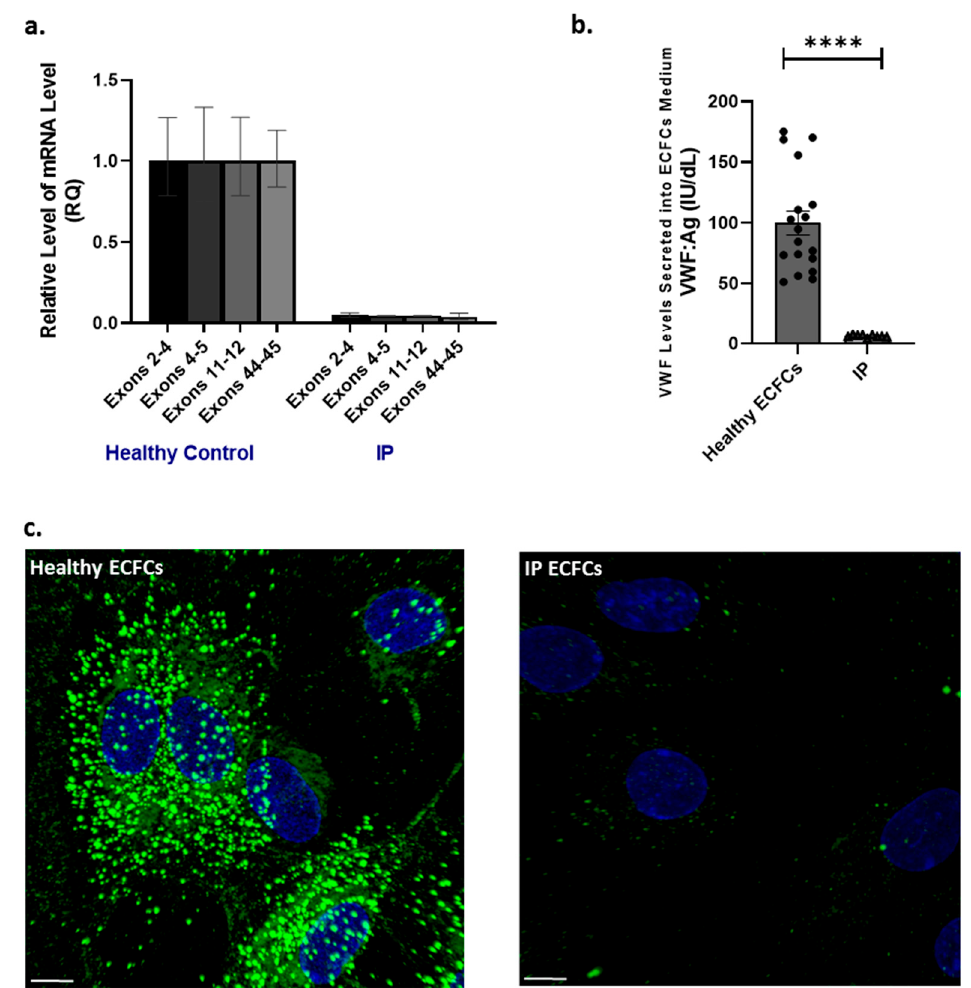
Figure 3. Von Willebrand factor (VWF) mRNA expression, as well as VWF secretion and intracellular storage, in endothelial colony-forming cells (ECFCs). ( a ) Illustration of comparative VWF mRNA levels in the index patient (IP) ECFCs quantified by real-time PCR, using primer/probe combinations directing four different sites in VWF cDNA, across exons 2–4, 4–5, 11–12, and 43–45. The measurements were performed based on the comparative C T ( ∆∆ C T ) method. Measurements of VWF mRNA levels were normalized to endogenous glyceraldehyde-3-phosphate dehydrogenase (GAPDH) or actin beta (ACTB) mRNA. ( b ) Graph of the mean of VWF antigen (VWF:Ag) levels in the medium of ECFCs obtained from IP (three independent ECFC isolations, three different passages each; N = 9) and six healthy donors (three different passages each; N = 18). ( c ) Immunofluorescence images of ECFCs isolated from the IP and healthy individuals. In healthy ECFCs, VWF (green) is deposited in stick-shaped organelles, resembling Weibel–Palade bodies (WPBs). However, VWF staining in the IP-ECFCs showed almost a lack of WPB formation, except for a few WPBs (1 to 3) in some cells. The scale bar is 10 µ